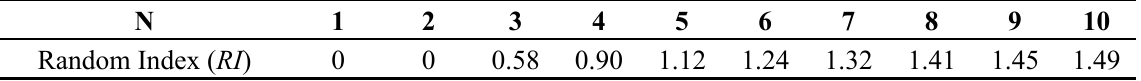
Table 2. Random index ( RI ) used to compute consistency ratios ( CR